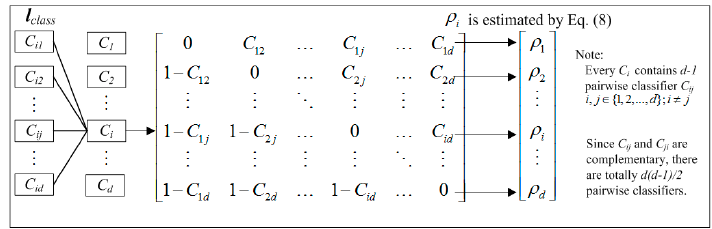
Figure 3. The proposed pairwise coupling strategy.